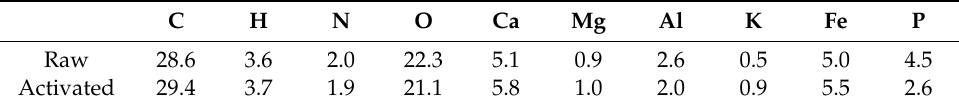
Table 1. Elemental composition (%) of hydrochar variants used in this study.